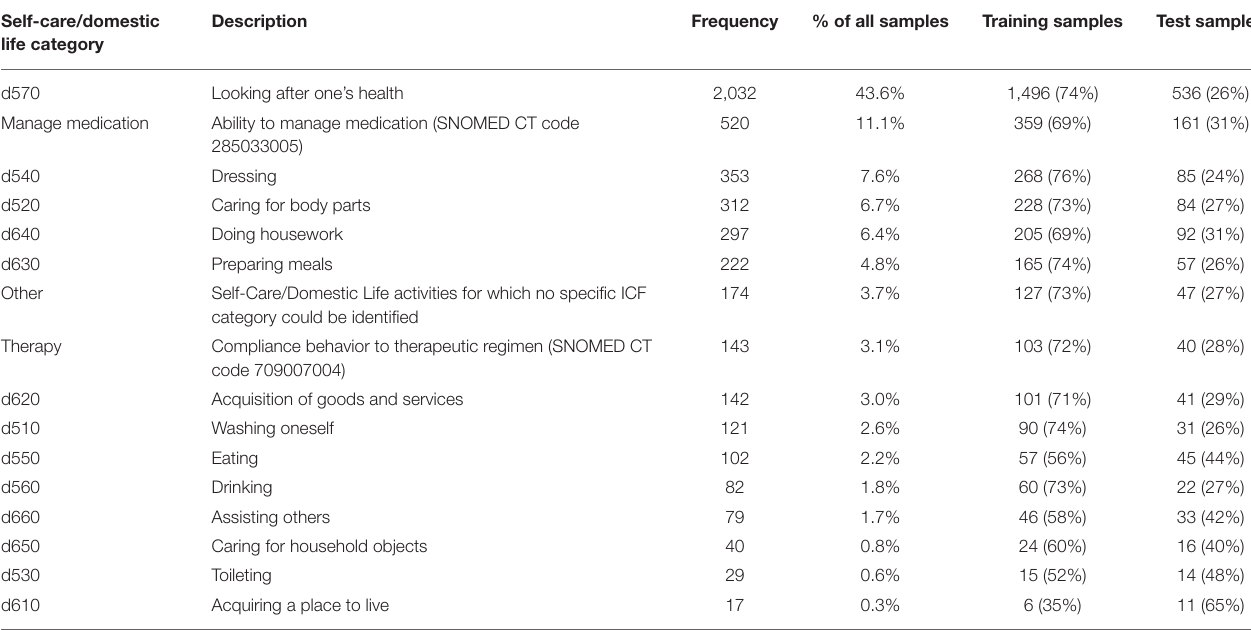
TABLE 4 | ICF category descriptions and frequencies for Self-Care/Domestic Life dataset (4,665 samples total). Self-care/domestic life